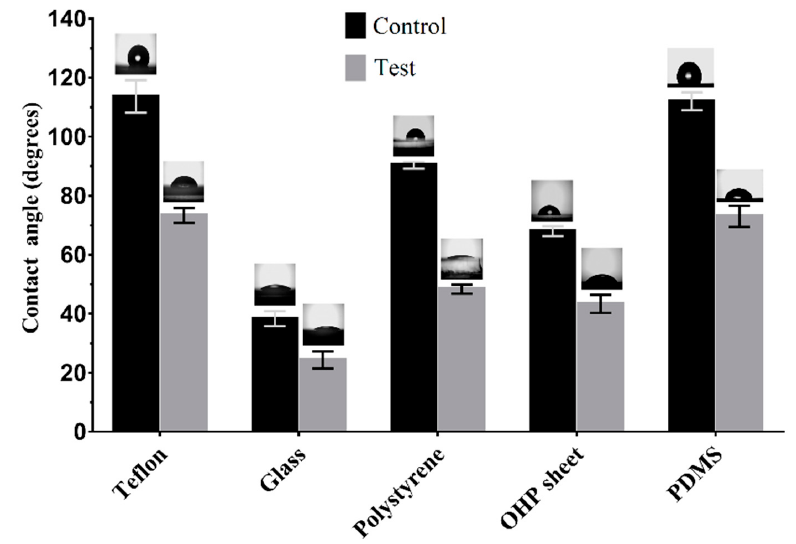
Figure 4. Measurement of contact angle (CA) (degrees) for biosurfactant (BS) obtained from L. acidophilus NCIM 2903 on different surfaces, OHP: Overhead Projector Transparent sheet; PDMS: polydimethlysiloxane.